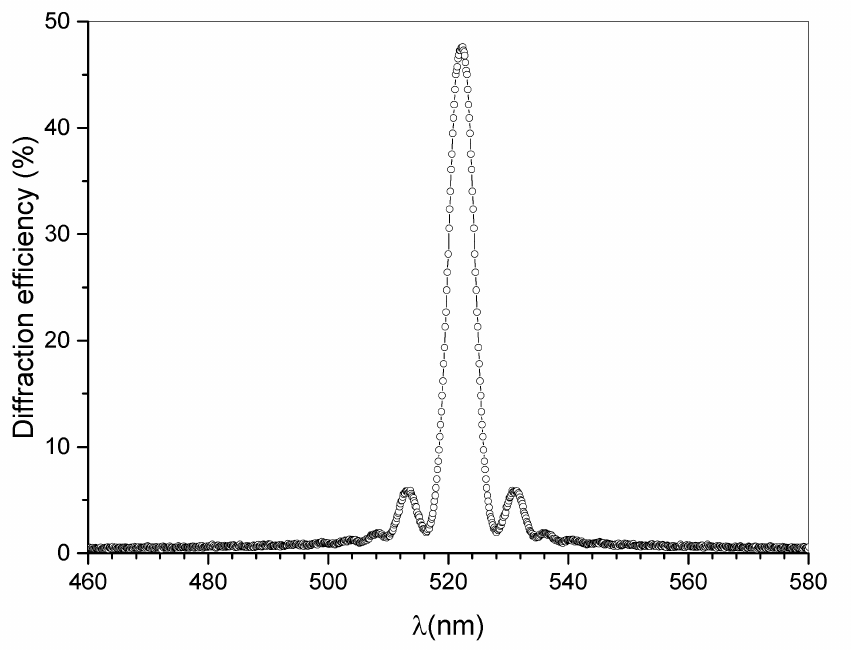
Figure 2. Typical normalized sample transmission measured using white light, impinging perpendic- ularly to the glass slides, and connected to a spectrometer.